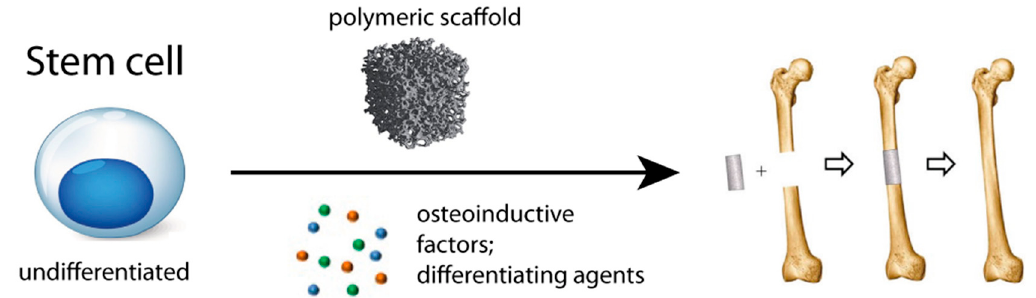
Figure 1. Tissue engineering approach to bone repair: undifferentiated stem cells were seeded within polymeric scaffolds, together with differentiating agents (e.g., dexamethasone) and osteoinductive agents and then implanted in vivo.